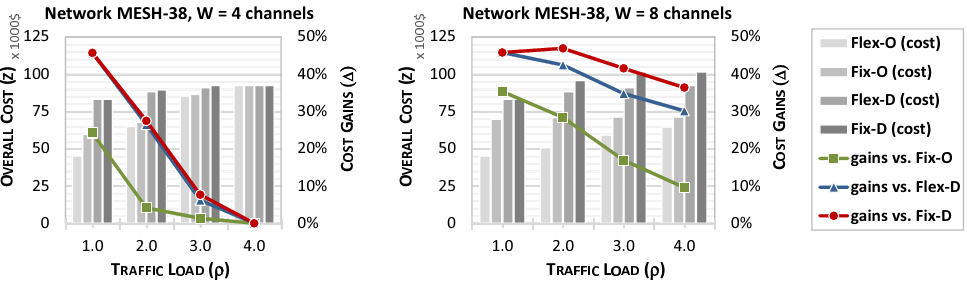
Figure 8. Overall network cost in different scenarios (bars) and cost gains achieved with flex-O vs. reference scenarios (lines) as a function of traffic load ( ρ ) for different WDM capacities ( W ) in